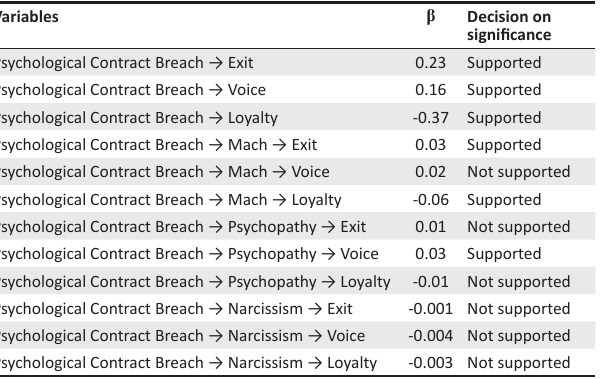
TABLE 2: Effects table.